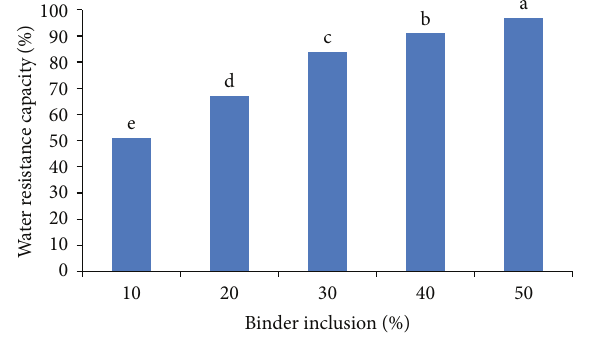
Figure 3: Effect of binder on water resistance of briquette. Means of the same letter are significantly different ( 𝑃 < 0.05 ).